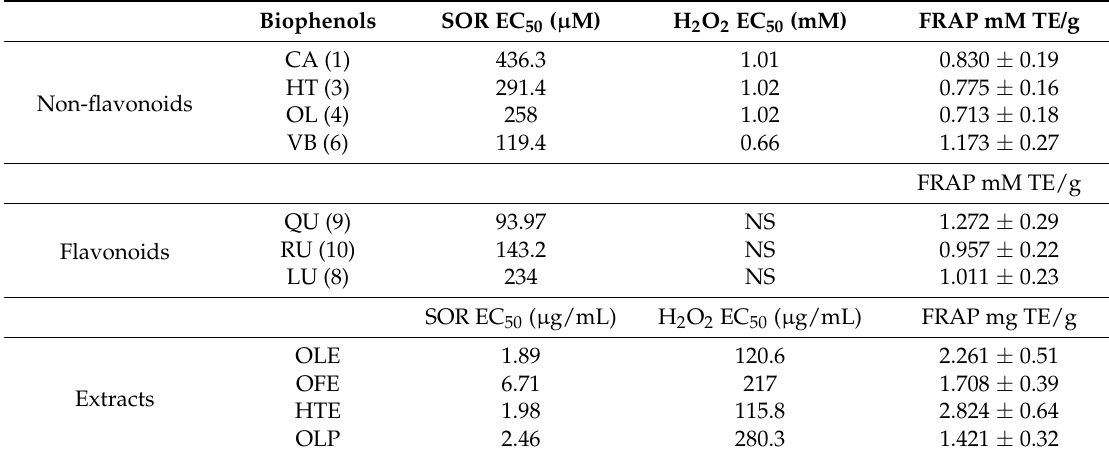
Table 2. SOR scavenging, H 2 O 2 scavenging and FRAP value of olive